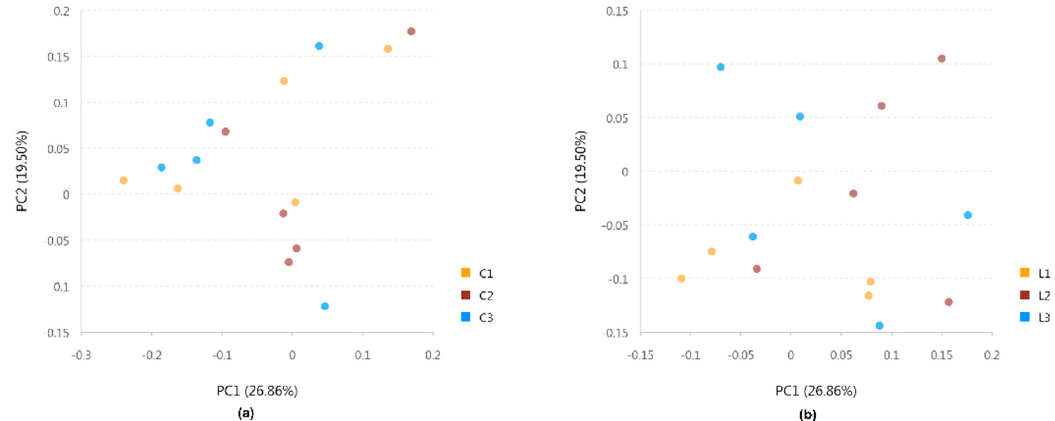
Figure 1. Principal coordinated analysis (PCoA) of rumen bacterial communities based on weighted UniFrac distances in the two diets. ( a ) Standard energy and standard protein (C) C1, C2 and C3 indicate rumen samples collected from the first, second and third month in the C diet group, respectively; ( b ) low energy and low protein (L) L1, L2 and L3 indicate rumen samples collected from the first, second and third month in the L diet group, respectively.